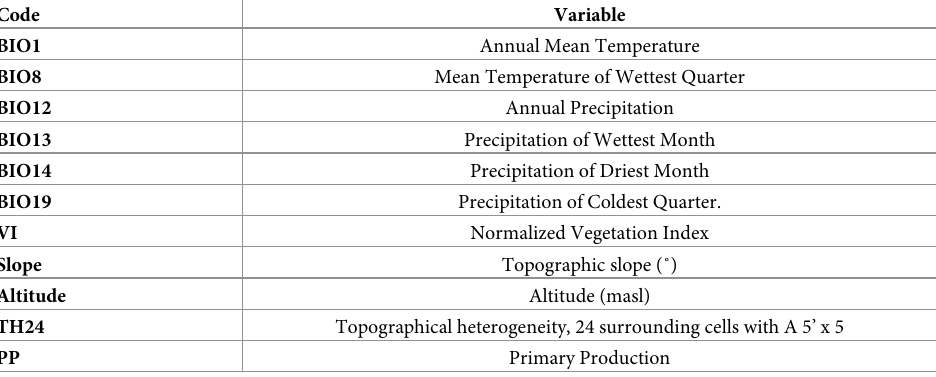
Table 1. WorldClim bioclimatic